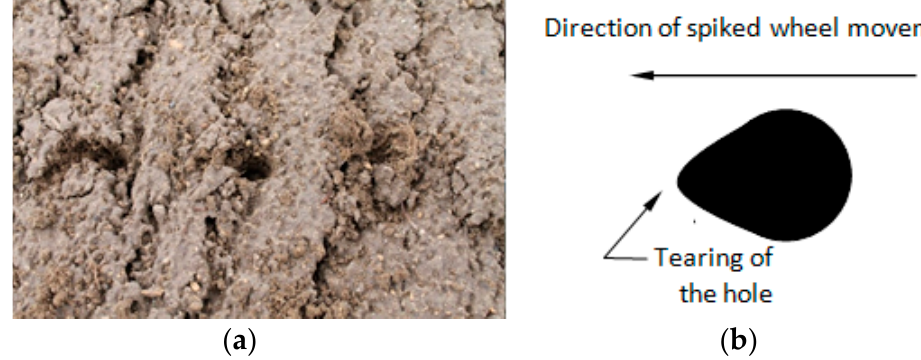
Figure 4. A tractor-pulled dibbler with a set of spiked wheels. However, the tractor-pulled dibbling machine is inadequate with respect to producing holes of acceptable quality. As the spiked wheels roll along the ground, holes are punched into the bed. The primary problem with this method is variation in the depth of the holes, non-round holes due to tearing and disruptions to the pesticide layer, as shown in Figure 5 (left). This is due to the motion of the wheels, which are pulled by the tractor as illustrated in Figure 5 (right). The trajectory of the pins forms a ‘torn’ hole with a tearing shape instead of a circular shape. The non-round holes lead to cuttings being planted non-perpendicular to the ground. This causes bends in the stem as they grow and results in rejection.